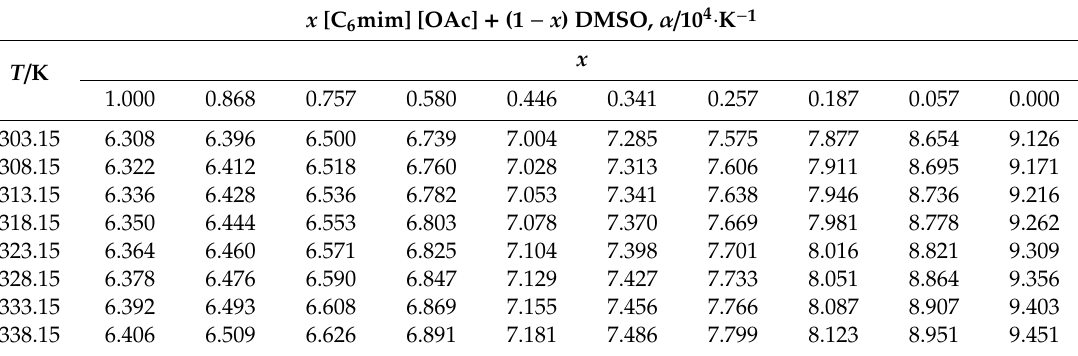
The relative standard uncertainty ( u r ) is u r ( ρ ) = 0.005. Table 8. Thermal expansion coe ffi cients of [C 6 mim] [OAc] with organic solvent of